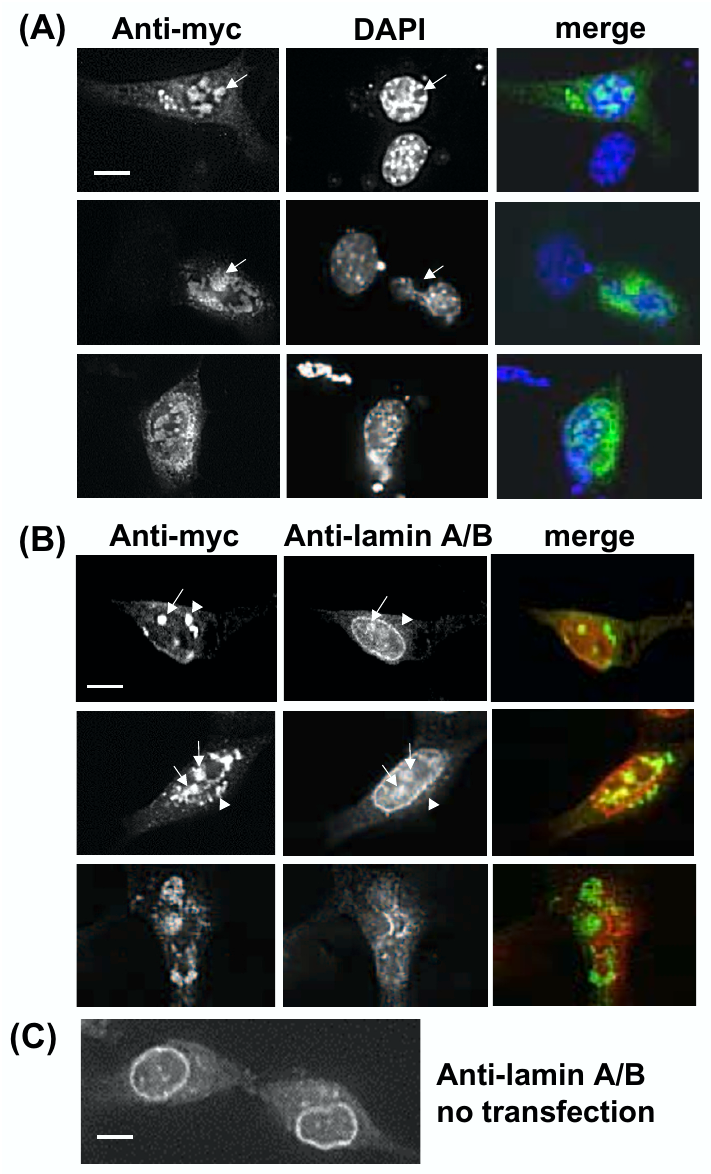
Figure 4 Disruption of nuclear architecture by Rab24(D123I) inclusions. NIH 3T3 cells expressing mycRab24(D123I) were processed for immunofluorescence microscopy 24 h after transfection. (A) The inclusions detected by staining with the anti- myc monoclonal antibody appeared to occupy areas of the nucleus devoid of DAPI staining (arrows). In some cells (upper pan- els) the nucleus was well defined, and it was possible to distinguish between inclusions localized inside and outside the nucleus. In other cells (lower panels), the inclusions were more diffuse, the nucleus was distorted, and it was difficult to discern the boundaries between the nuclear and cytoplasmic compartments. (B) mycRab24(D123I) inclusions were localized with rabbit anti-myc polyclonal antibody followed by FITC-conjugated GAR IgG. The nuclear envelope was highlighted by co-staining with a monoclonal antibody against lamins A and B, followed by rhodamine-conjugated GAM IgG. In some cells with immunoreac- tive inclusions (upper panels) a well defined nuclear envelope was visible, whereas in others (bottom panels) the nuclear enve- lope appeared to be completely disrupted. Where both cytoplasmic and nuclear inclusions were present (top and middle panels), it appeared that the myc-reactive aggregates inside the nucleus contained lamins (arrows), while those outside the nucleus did not (arrowheads). For comparison, panel C shows the nuclear lamin staining typically observed in non-transfected cells. The scale bar represents 10